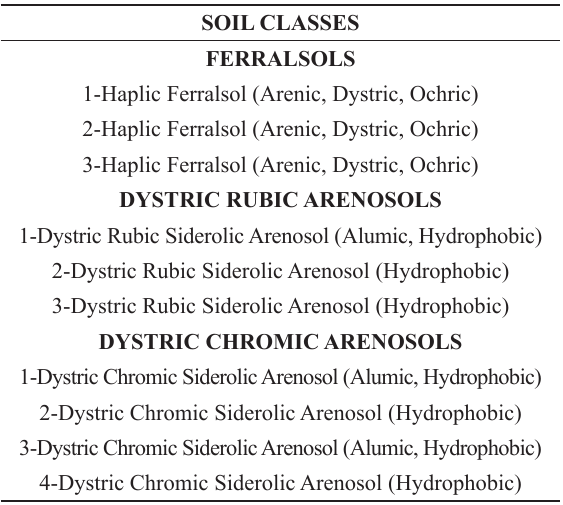
Soil classes according to the IUSS Working Group WRB- FAO (2014), sampled in the municipality of Glória, Bahia state,